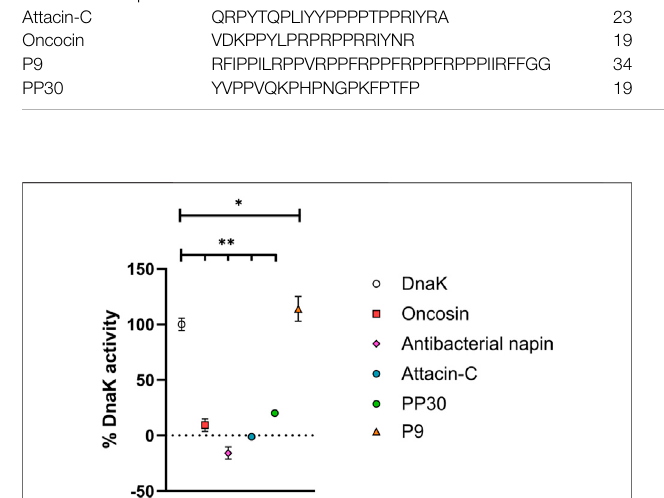
FIGURE 1 | Ability of potential new PrAMPs to impact DnaK activity. Each was incubated with DnaK for 1 h at 37 ° C and the free phosphate generated was detected with a Malachite Green-based stain. Activities are reported in % activity relative to DnaK positive and DnaK negative samples withconstraints at 0% activity. All peptides wereassayed at 300 µM. One-way ANOVA followed by Dunnett ’ s multiple comparisons test was performed to compare the control (DnaK) to each of the peptides, p < 0.05 (*) and p < 0.001 (**) are indicated.